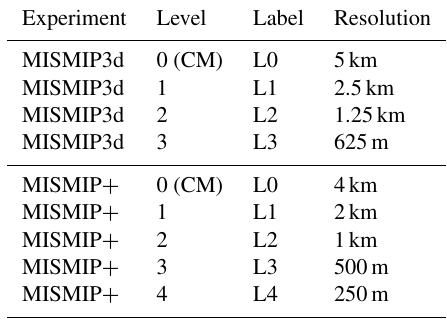
Table 1. Refinement criteria for the adaptive mesh refinement (AMR) simulations.